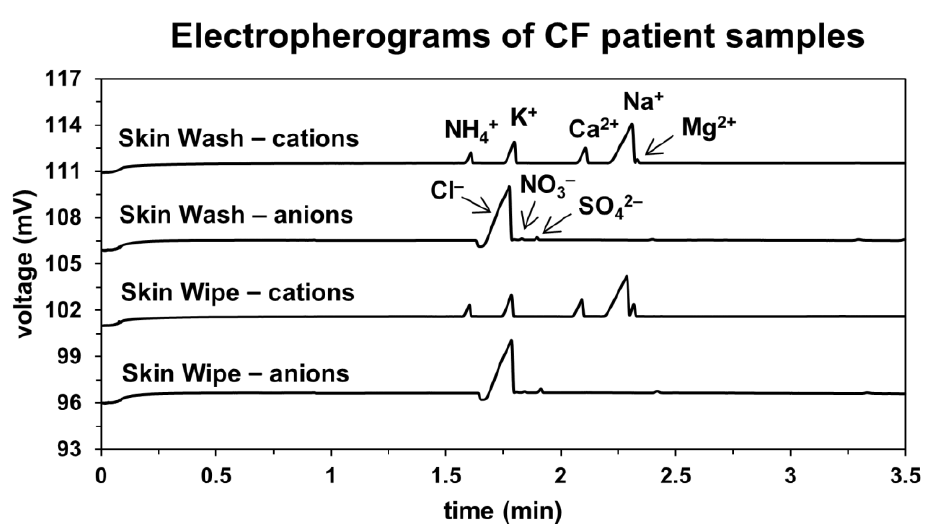
Figure 3. Electropherogram of a CF patient showing anion and cation analysis in skin-wash and skin-wipe samples. CE conditions: 20 mM MES/His, 2 mM 18-crown-6, 30 µM CTAB at pH 6. Injection: 50 mbar/5 s, Separation voltage +15 kV for cations, −15 kV for anions. Samples were diluted 1:1 with DI water.